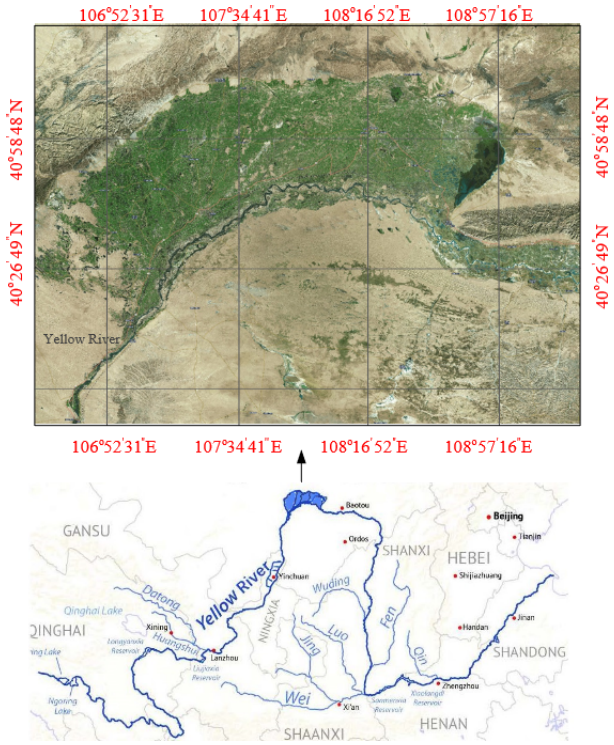
Figure 1. Hetao irrigation district longitude–latitude projection im- age © Google